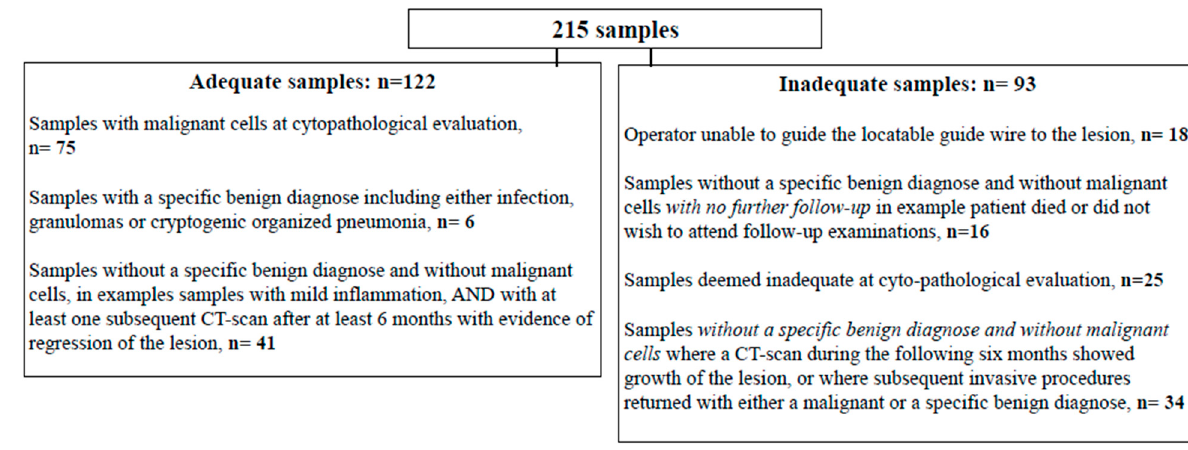
Figure 2. Description of adequate and inadequate procedures.